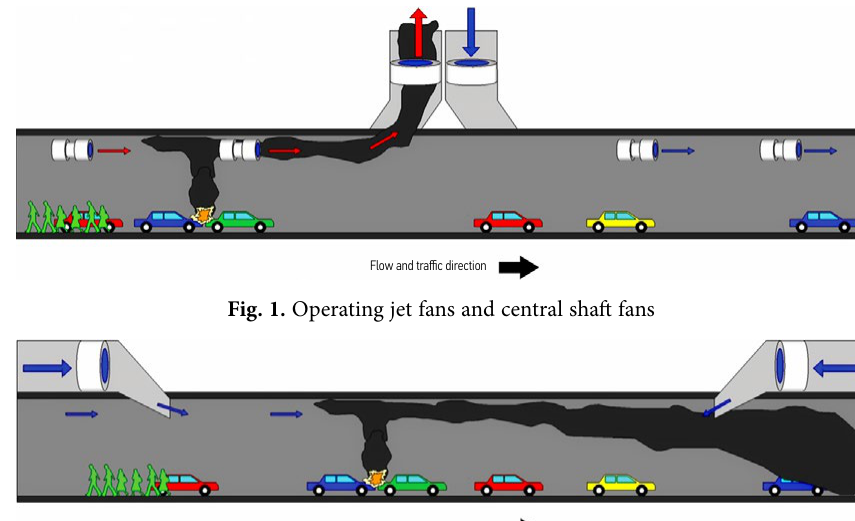
Flow and traffic Fig. 2. Operating central fans equipped with Saccadro nozzle